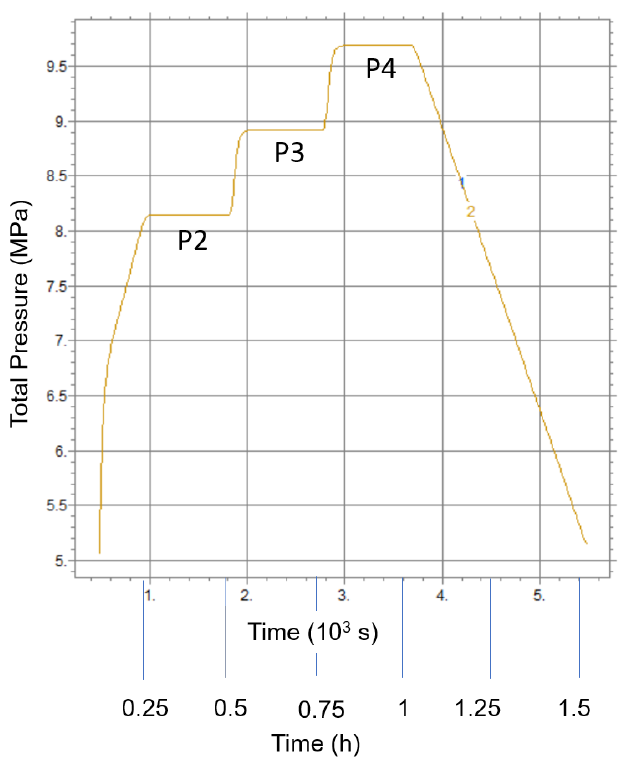
Figure 14. Simulated evolution of the total pressure for experiments #P2 to